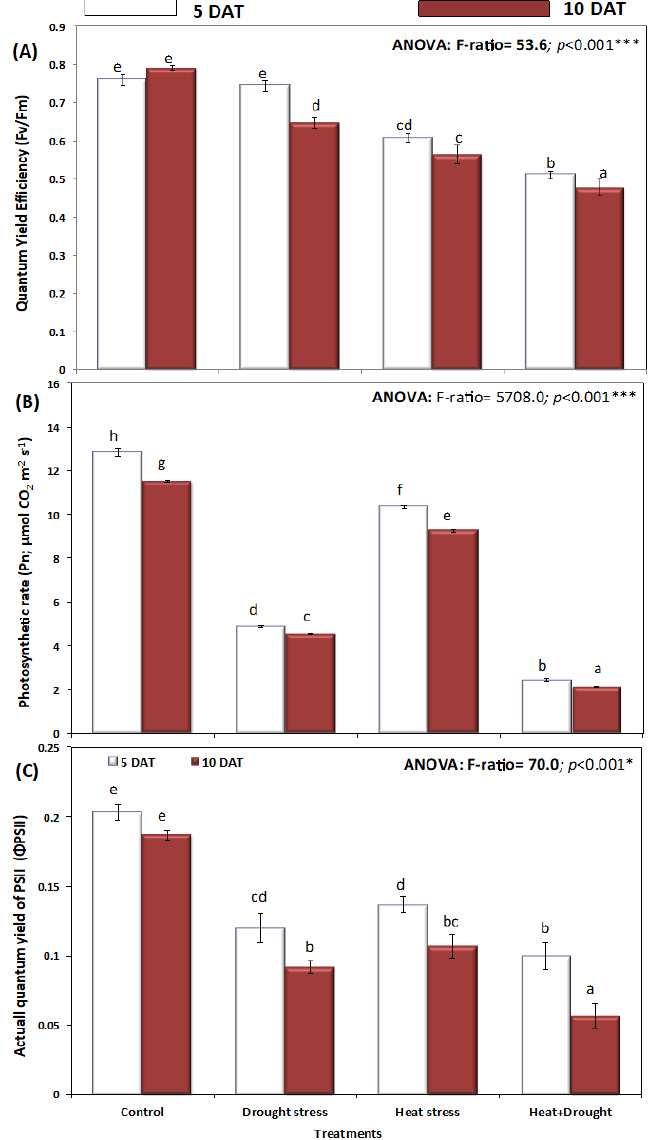
Figure 7. E ff ect of drought, heat, and interaction between drought and heat stresses on ( A ) quantum yield e ffi ciency ( Fv / Fm ), ( B ) photosynthetic rate (Pn), and ( C ) actual quantum yield e ffi ciency ( Φ PSII) of A. sieberi alba . Data expressed as mean of triplicates, error bars represent standard error for means. Means marked with di ff erent letters are significantly di ff erent according to ANOVA and DMRTs at p <